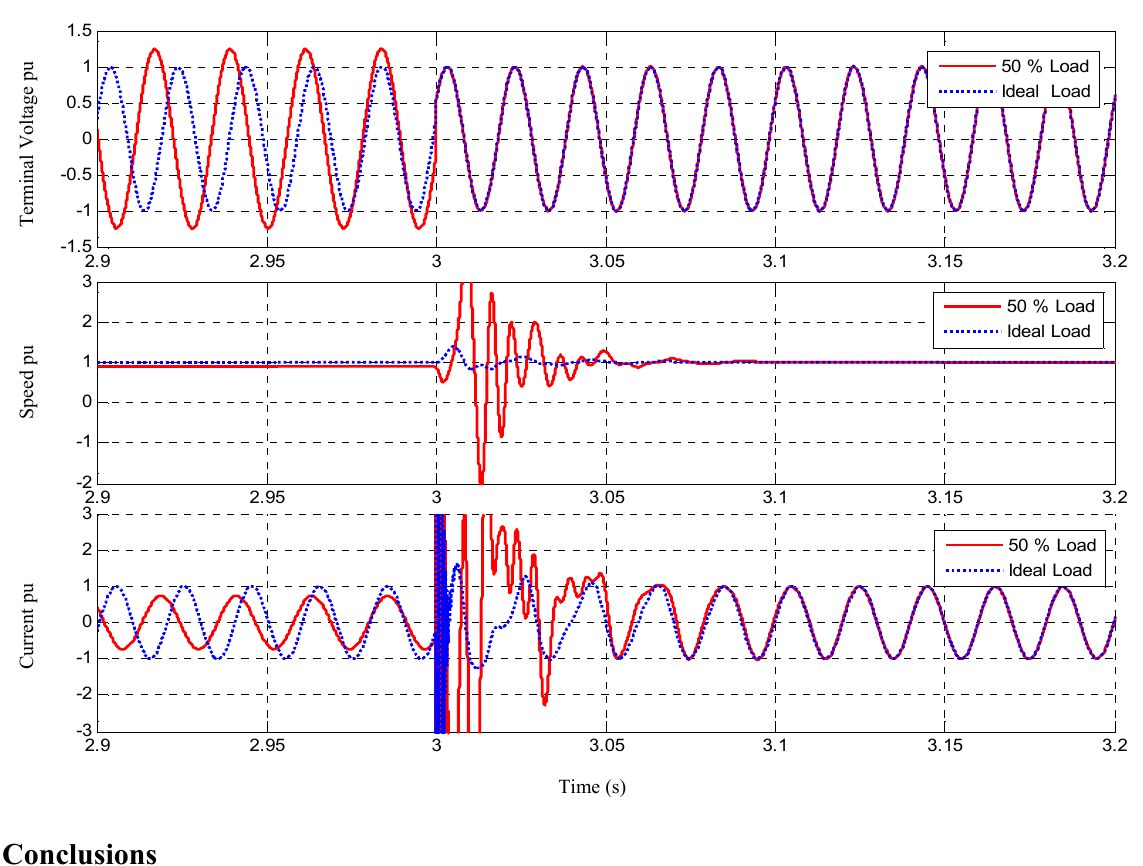
Figure 16. Reconnection of the IG at 3